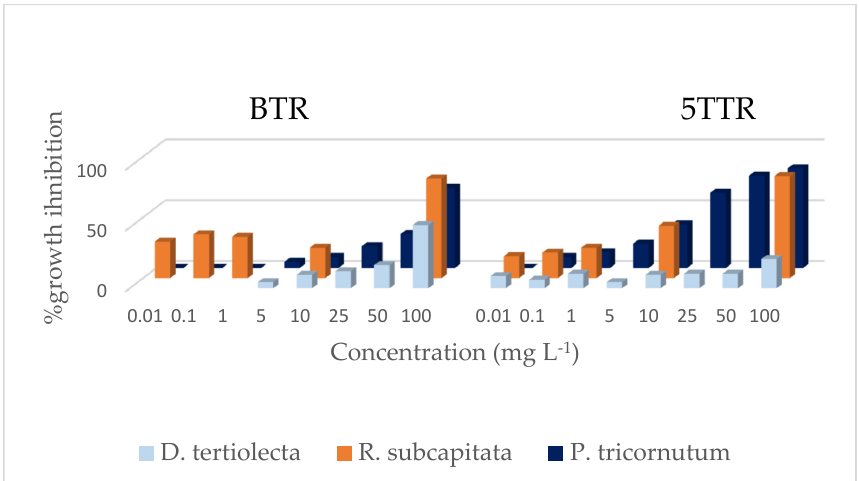
Figure 5. Values of the percentage of growth inhibition produced by the two benzotriazoles on the three algal species.